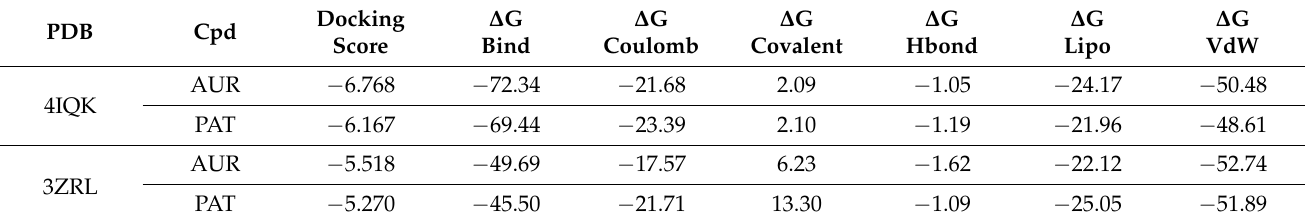
Table 3. The docking scores and binding energies of auranamide and patriscabratine in KEAP1 Kelch